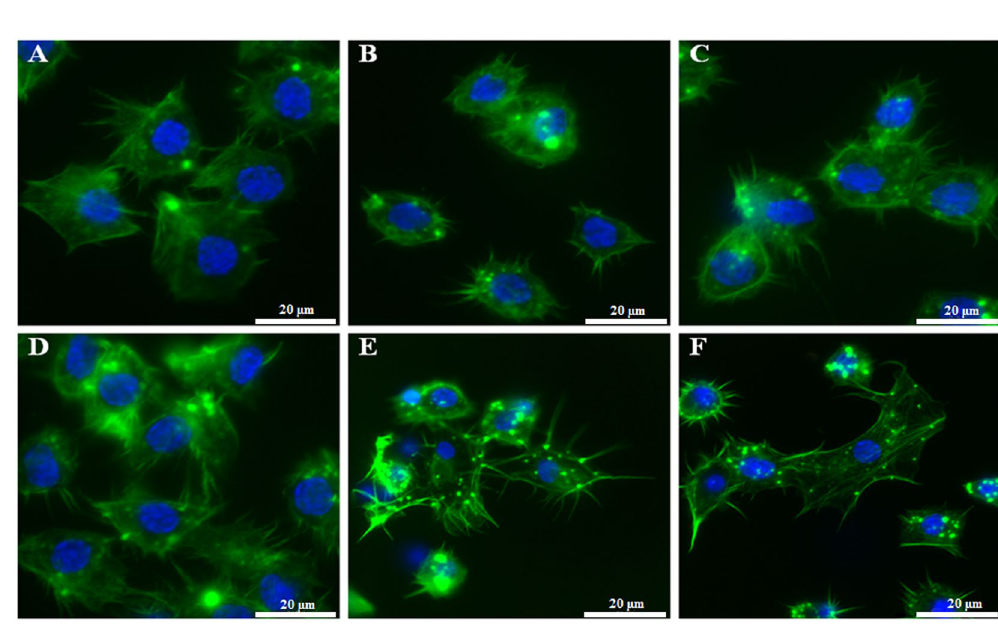
Figure 3. The in vivo short- and long-term haemocyte bioassay showing viable, adhesive haemocytes isolated from the insects injected with h-BN-OH-n or topically exposed to h-BN-OH-n. Haemocytes: 2 hours after saline injection ( A ) and 2 days ( D ) after topical application of saline (controls), 2 hours after injection of 2 ng ( B ) or 2 µ g ( C ) of h-BN-OH-n, 2 days after topical application of 2 ng ( E ) and 2 µ g ( F ) of h-BN-OH-n. The active caspases (1–9) were stained with SR-VAD-FMK (no red = no active caspases), the F-actin cytoskeleton was stained with Oregon Green 488 phalloidin (green) and DNA was stained with DAPI (blue). Scale bars: 20 µ